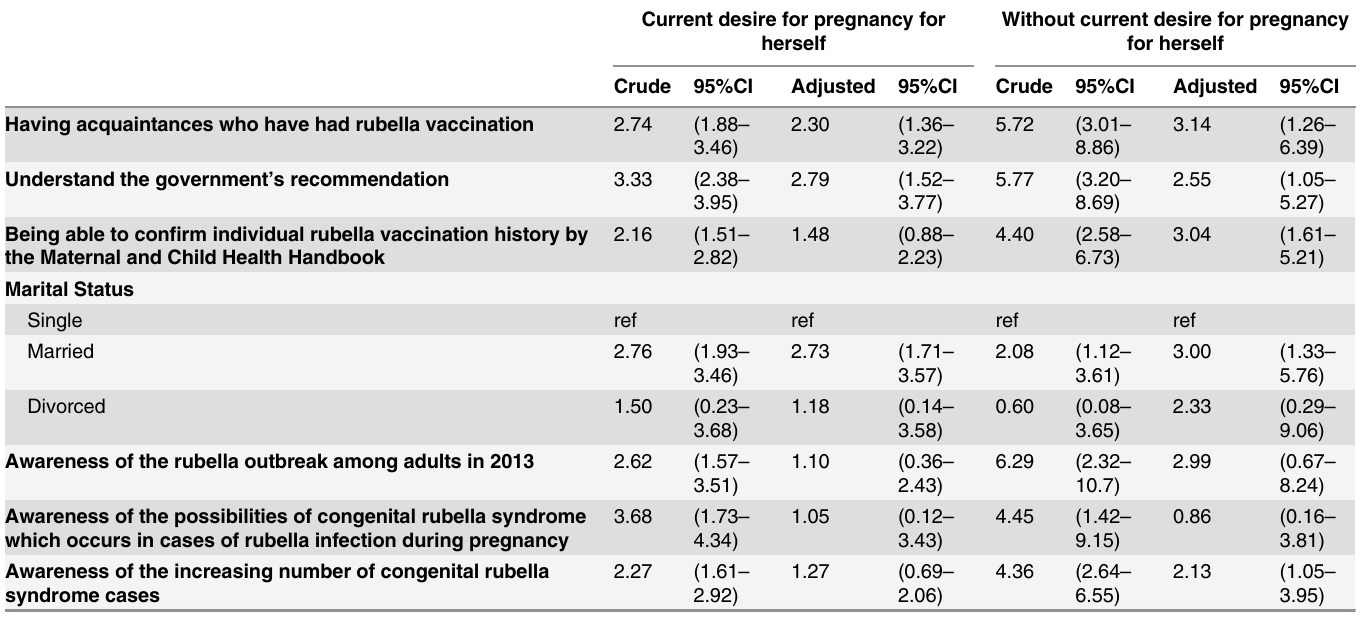
Table 7. Statistical associations between vaccination or antibody testing for rubella in 2013 and current desire for pregnancy for herself for women.